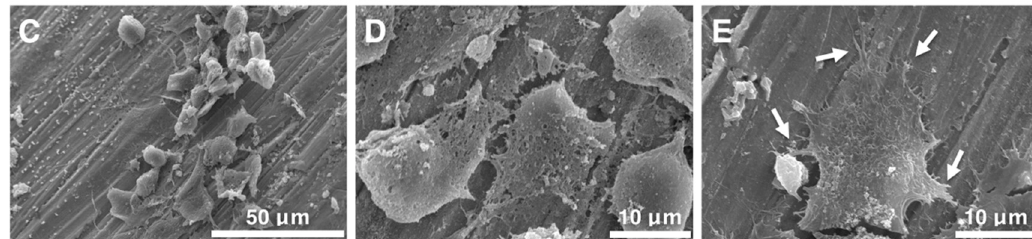
Figure 5. SEM images of MG63 cell line cultured for 12 h on Mg 60 Zn 35 Ca 5 BMGC. ( A ) MG63 cells adhesion on two vertical solid surfaces. ( B – D ) MG63 cells were stacked on the surface of Mg 60 Zn 35 Ca 5 BMGC with good adhesion and spreading morphology. Cells were not only attachment between pseudopodia and the surface of Mg 60 Zn 35 Ca 5 BMGC but also morphology of cell-cell interaction can be observed clearly. ( E ) The cytoskeleton of MG63 cells was well expanded and presented a pronounced spreading and formation of pseudopodia on surface of Mg 60 Zn 35 Ca 5 BMGC (indicated by arrow).